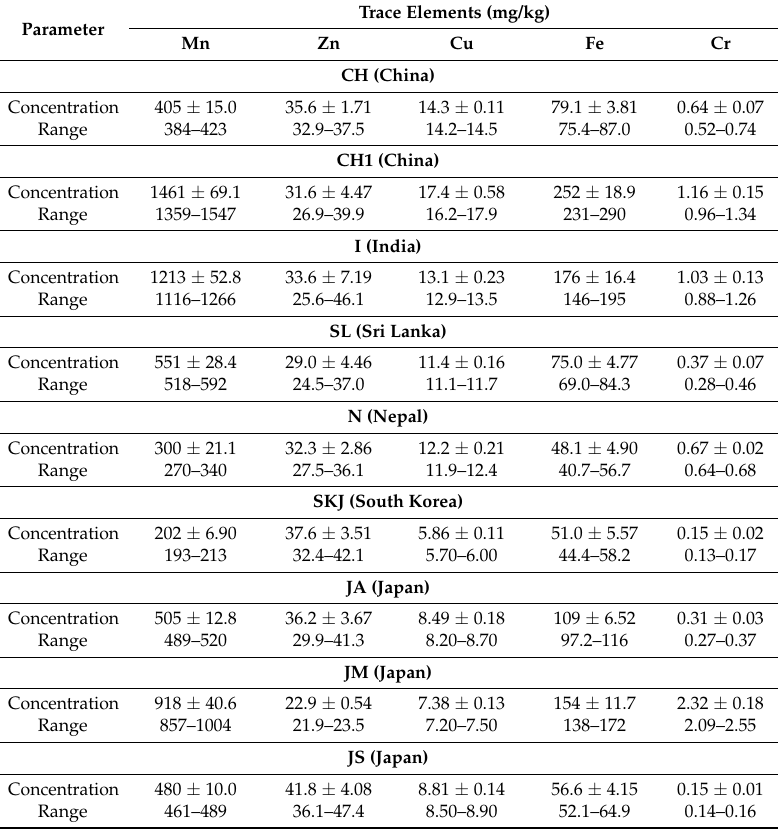
Table 3. The average content of trace elements in green tea samples according to their origin (including tea type or